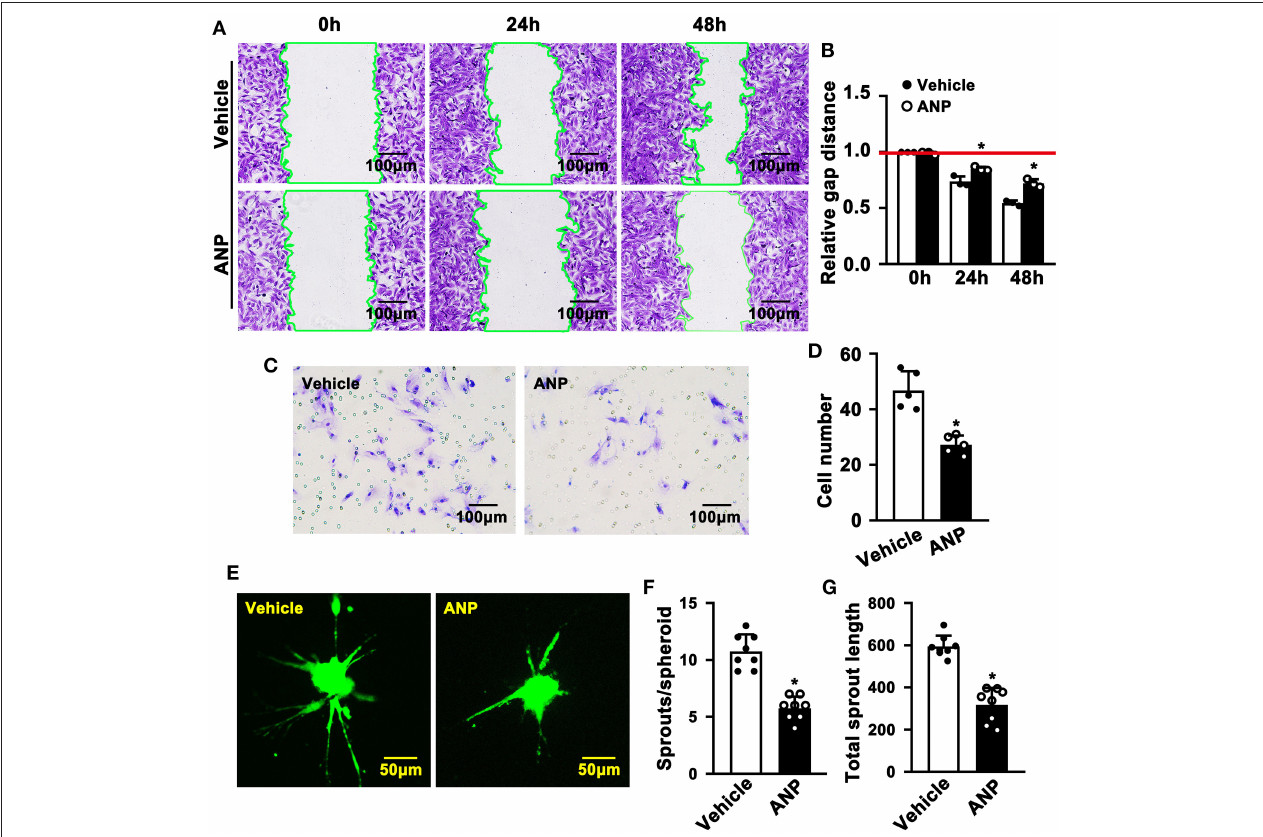
FIGURE 4 | Andrographolide inhibits migration of rat smooth muscle cells. (A) A wound scratching assay was performed to determine whether Andrographolide treatment (5 µ M) suppressed SMC migration. The number of scratch gaps at 24h and 48h is exhibited in (B) ( n = 5). (C) A Boyden chamber cell migration assay was performed in the presence of Andrographolide (5 µ M), the migrated cells were visualized by crystal violet staining, and cell numbers are exhibited in (D) ( n = 5). (E) A spheroid sprouting assay was performed in the presence of Andrographolide (5 µ M), the sprouting of SMCs was visualized by calcein AM staining. Quantification of sprouts and sprout length is exhibited in (F,G) ( n = 8). The analysis data are expressed as means ± SEM. * P <